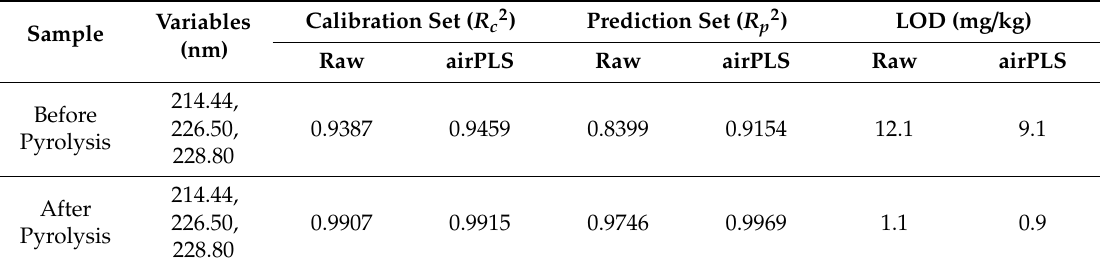
Table 2. The results for multiple regression analysis based on three Cd emission